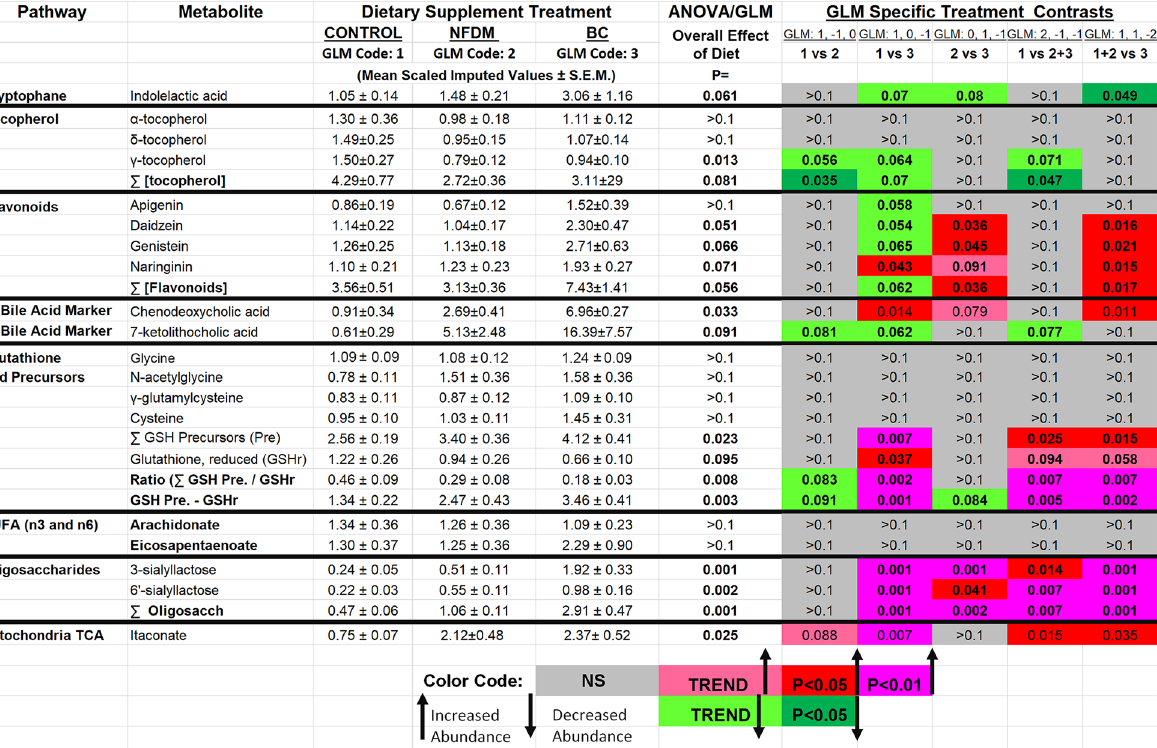
Data represent the means SEM of the Scaled Imputed Values of metabolites that were increased by either BC or NFDM identified by the metabolomic analysis to be ± consistently changes across the two experimental replicates and the source(s) of the colostrum. Control, basal diet,